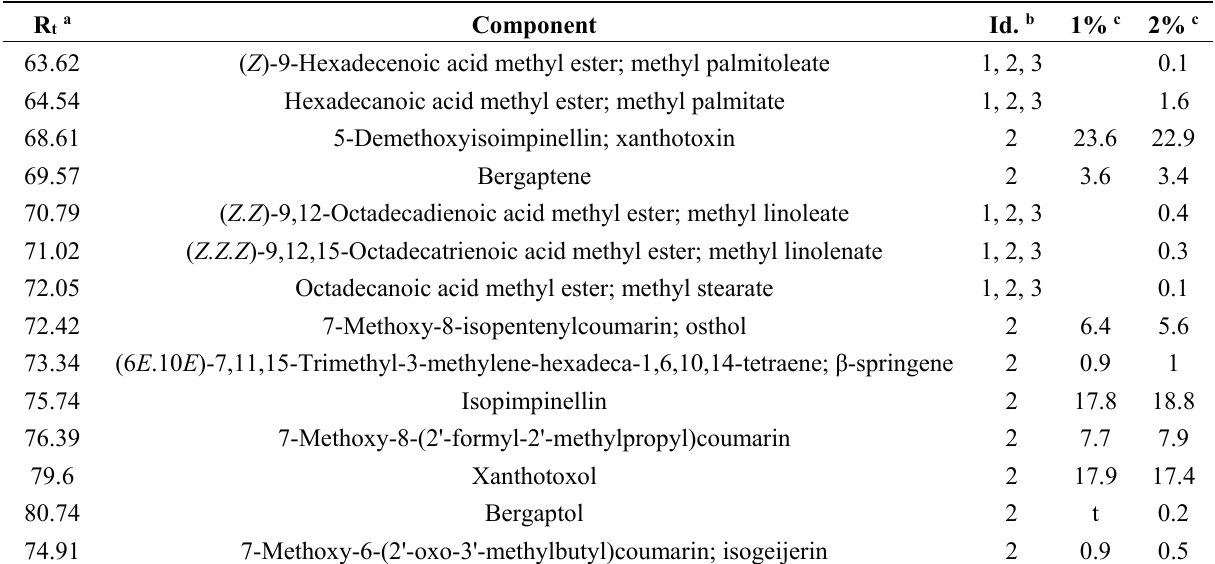
Table 1. GC-MS analysis of M. tomentosa petroleum ether